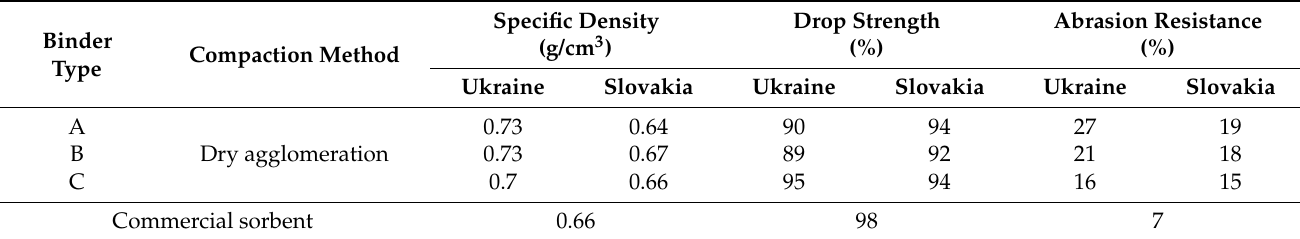
Table 3. Physical properties of the produced agglomerates and commercial